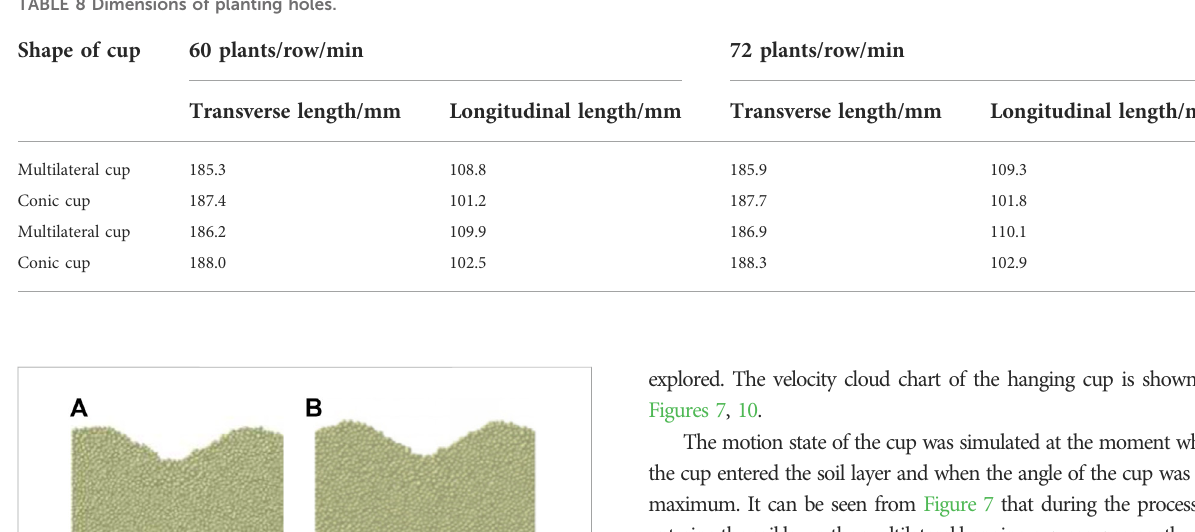
TABLE 8 Dimensions of planting holes.